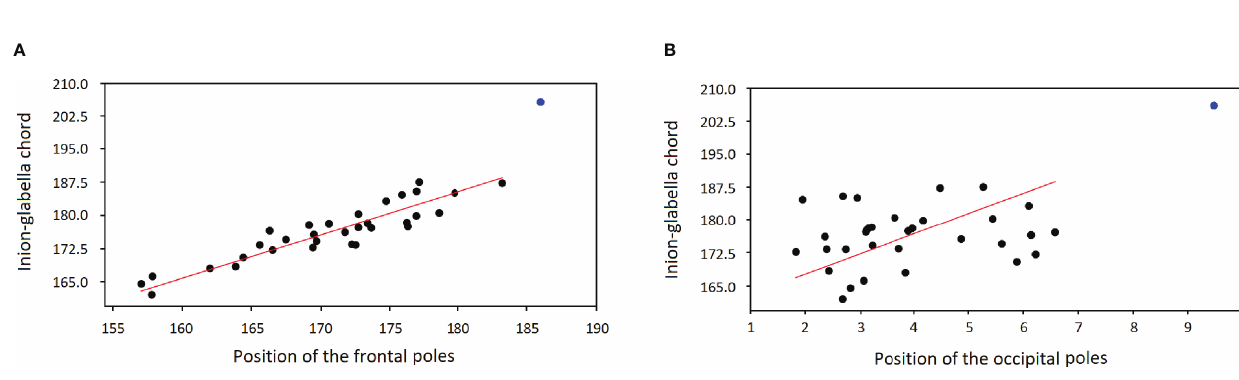
FIGURE 3 | Bivariate linear regression (RMA model) between the length of the skull (Y axis; Glabella-Inion length) and the position of the frontal (A) and occipital poles (B) on this axis (X axis, i.e. the position of the mean projection of the left and right poles on the Inion-Glabella chord). The blue dot shows the position of OL-23/77.